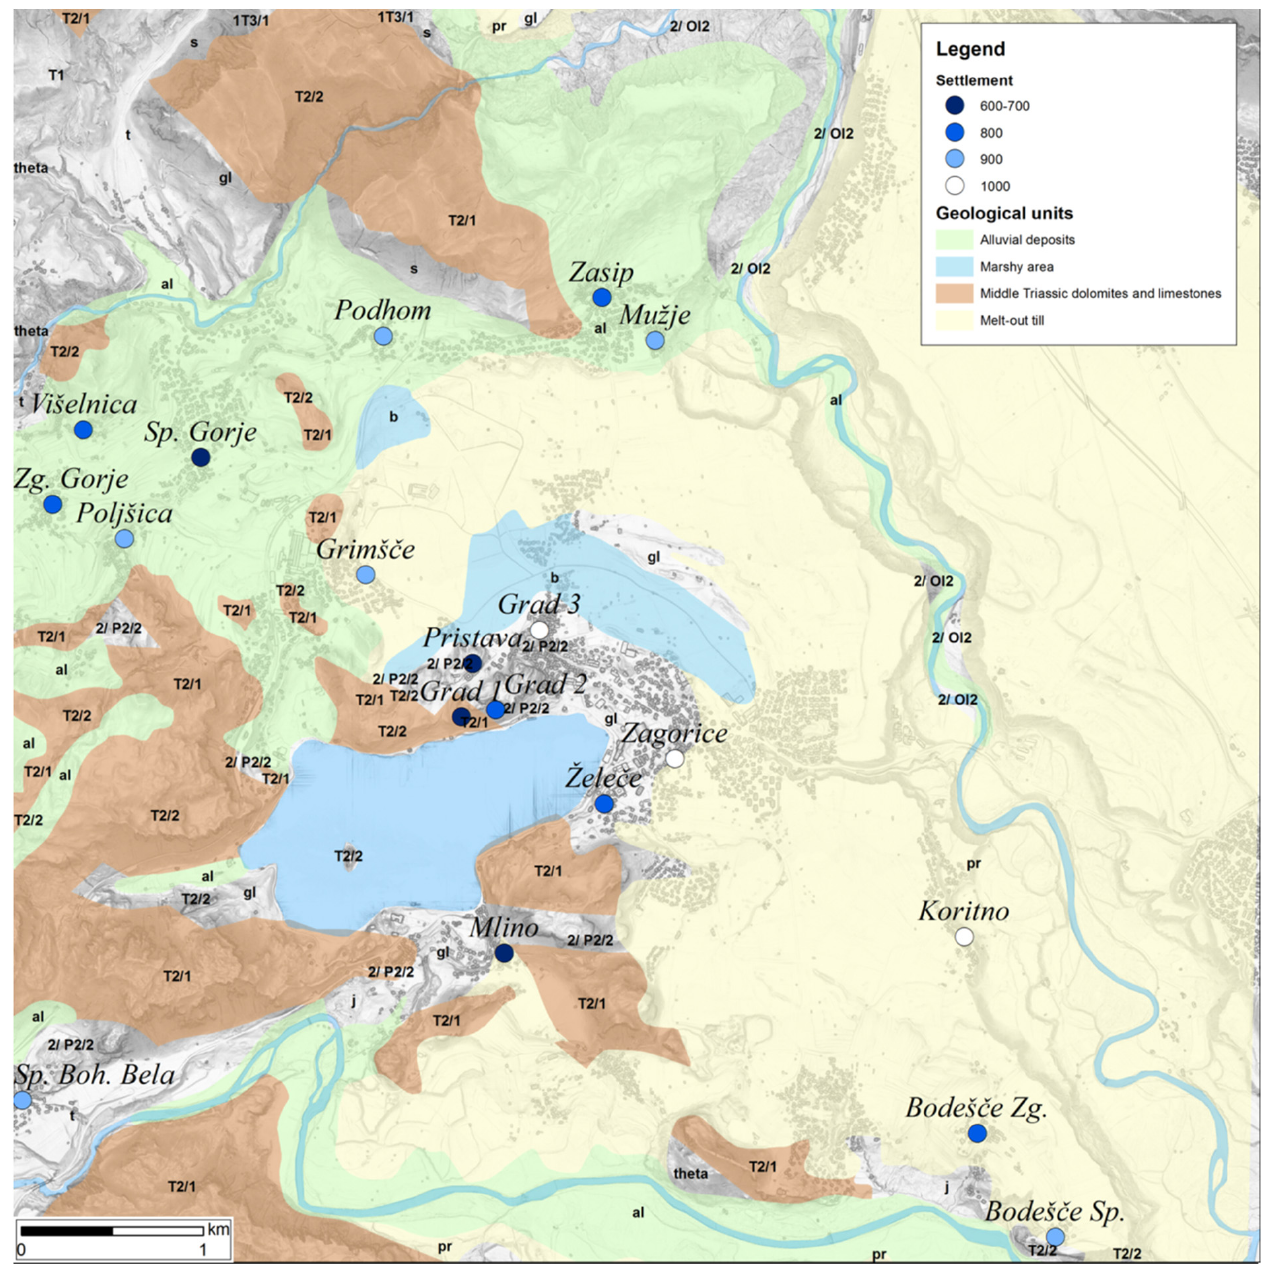
Figure A2. Bled microregion (decimal longitude and latitude coordinates of the map centre: 14.1139; 46.3752), geological background. The most main geological units prevailing in the study area are presented (source data adopted from [90–92]; North at the top).